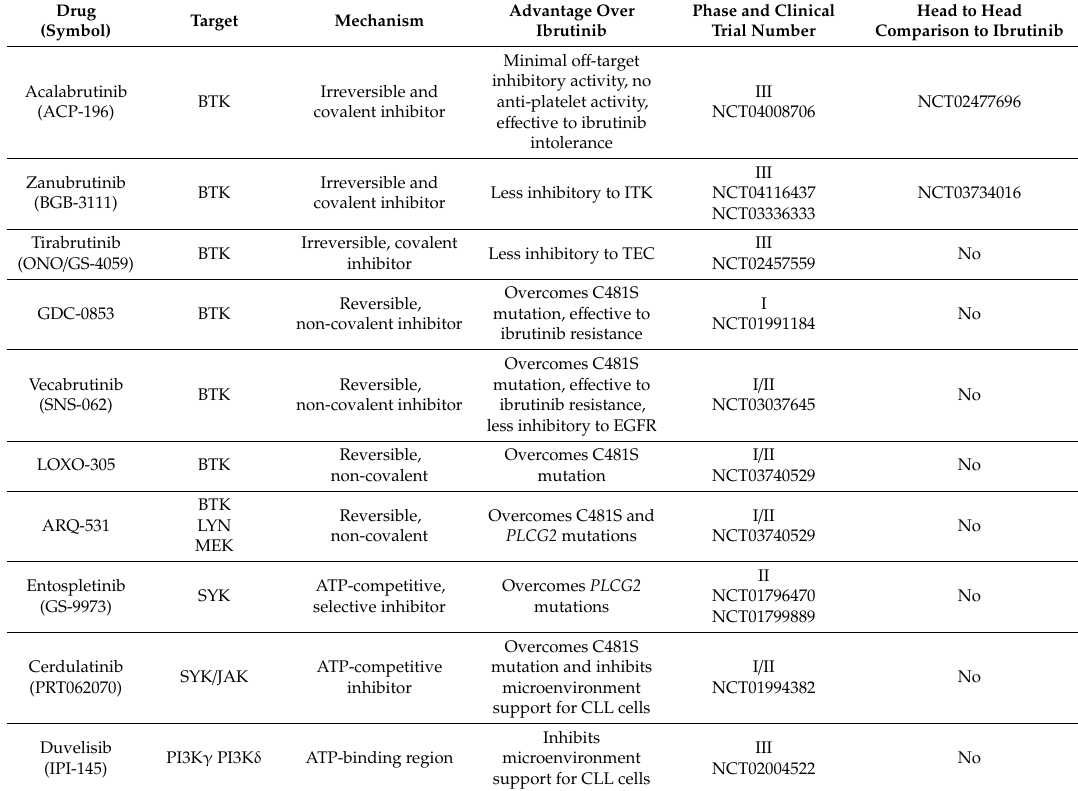
Table 1. Drugs with the potency to overcome ibrutinib resistance / intolerance. Drug